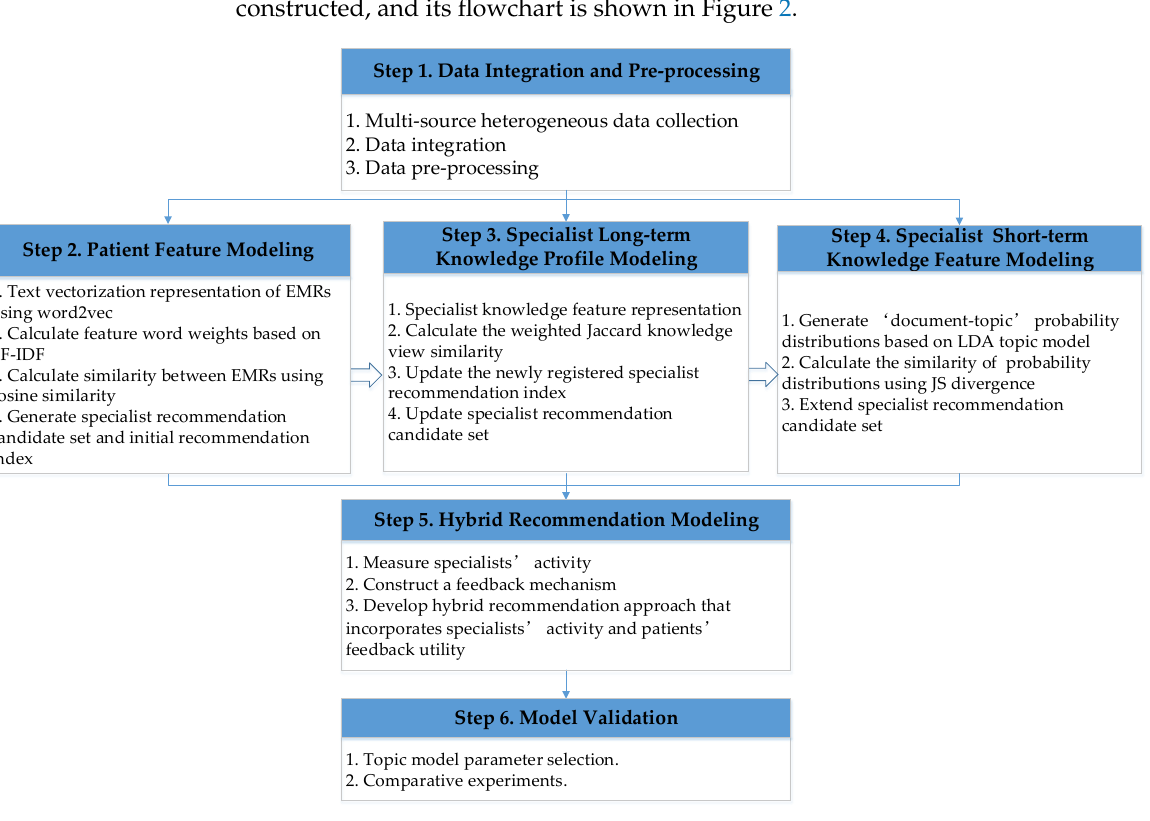
Figure 2. Self-adaptive telemedicine specialist recommendation approach flowchart.